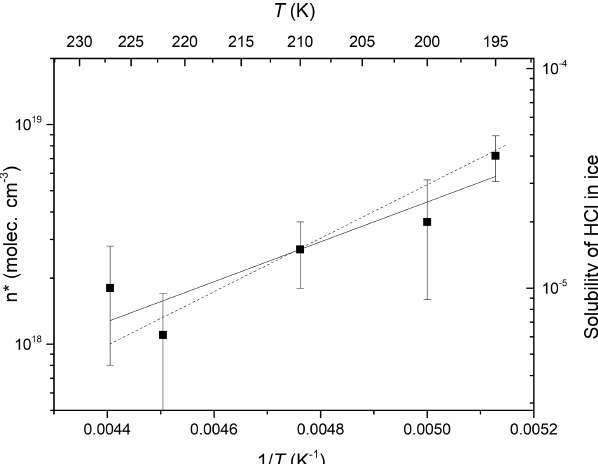
Figure 7. Arrhenius plot of n ∗ versus inverse temperature. The error bars represent the 1 σ standard deviation of the mean values derived from M HCl . The solid line is a fit to the data according to Eq. (7). The dotted line (right-hand y axis) represents the solubility of HCl in ice (as a unitless mole fraction for an HCl partial pressure simi- lar to those used in the present study) as measured by Thibert and Dominé (1997). The left and right y axes have the same relative span to enable the comparison of